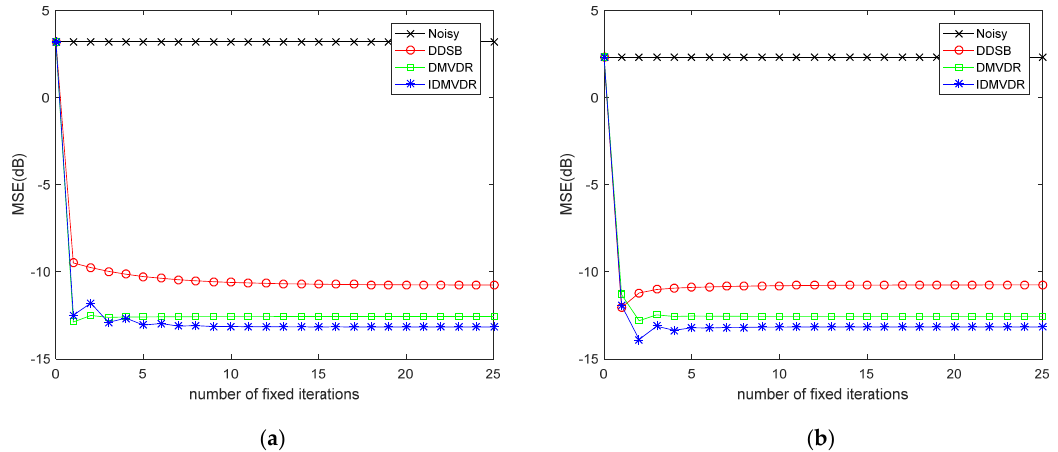
Figure 5. The MSE variations in the WASN with N d = 5: ( a ) MSE of node 4 in each iteration; ( b ) MSE of node 5 in each iteration.